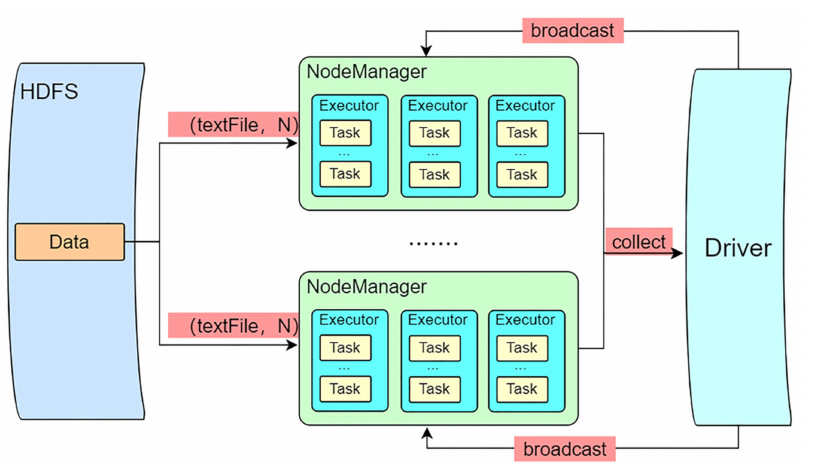
Figure 6. Spark-based parallelization algorithm for spatial adaptive filtering (red represents the different operators provided by